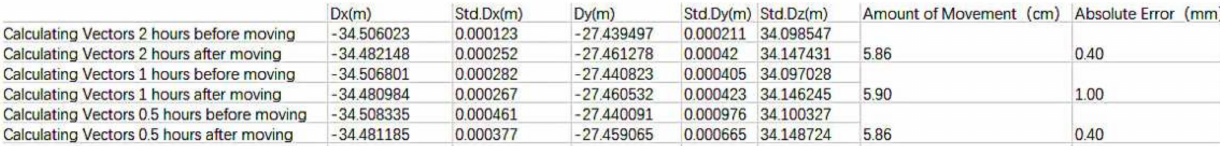
Figure 8. Mobile test